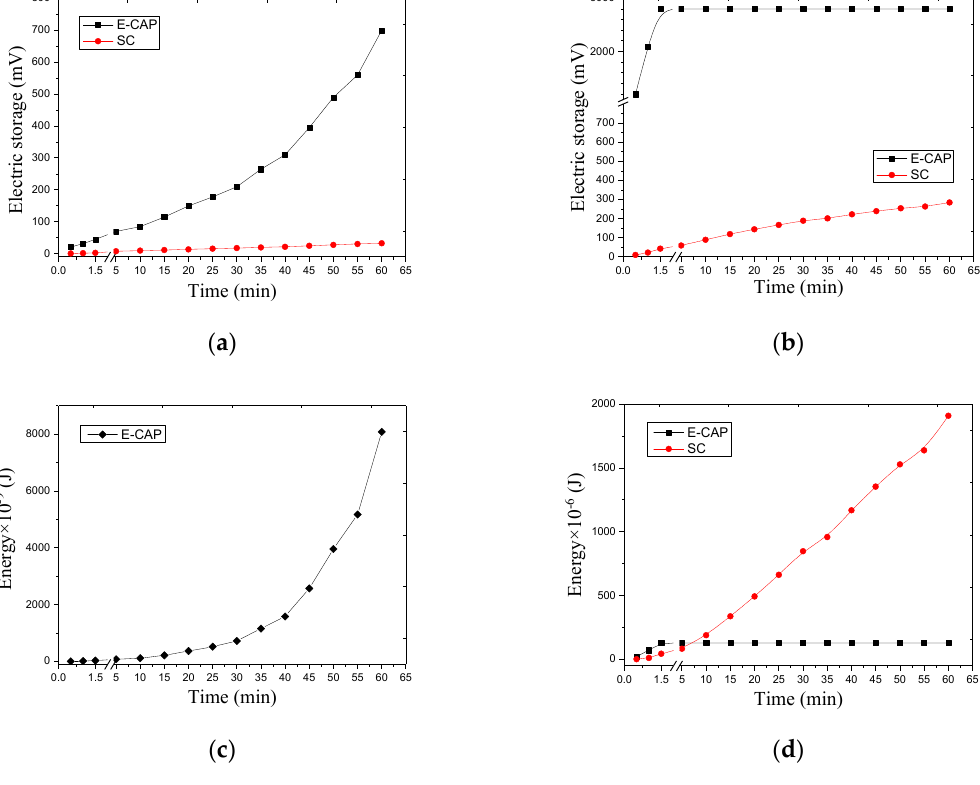
Figure 9. Voltage output and energy collected at different depths. ( a ) voltage at 2 cm; ( b ) voltage at the surface; ( c ) energy collected at 2 cm of E-CAP; and ( d ) Energy collected at the surface.